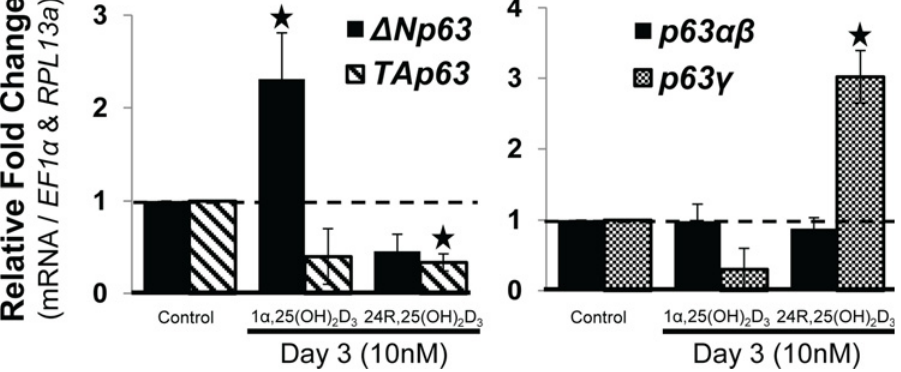
Fig 3. Vitamin D 3 metabolite 1 α ,25(OH) 2 D 3 increased mRNA expression of Δ Np63, while 24R,25 (OH) 2 D 3 altered mRNA splice variant expression of p63 γ during expansion. hMSC were seeded at 1,000 cells/cm 2 and grown under expansion conditions. hMSC were then treated (or not = control) once with the vitamin D 3 metabolites (Day 0) 1 α ,25(OH) 2 D 3 (10nM) or 24R,25(OH) 2 D 3 (10nM) for a 3-day period prior to RT-qPCR analysis of p63 gene products. RT-qPCR analysis of p63 isoforms (left panel, TA- and Δ Np63 ) and splice variant mRNA (right panel, p63 α / β and p63 γ ) expression. N = 3 independent experiments in triplicate. ( * ) p (cid:1) 0.05 compared to control (expanded, untreated hMSC). hMSC used were from a 7 and 22 year old